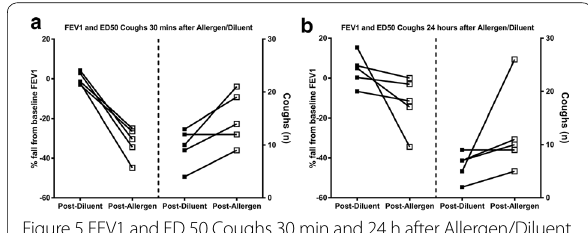
Figure 5 FEV1 and ED 50 Coughs 30 min and 24 h after